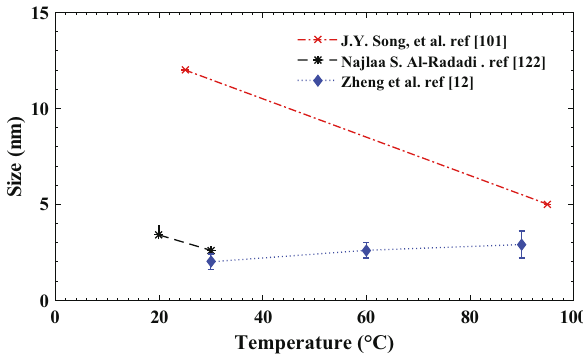
Figure 3: The e ff ect of reaction temperature on the particle size variation of Pt NPs, adapted from refs. [ 101, 122, and 12 ] .